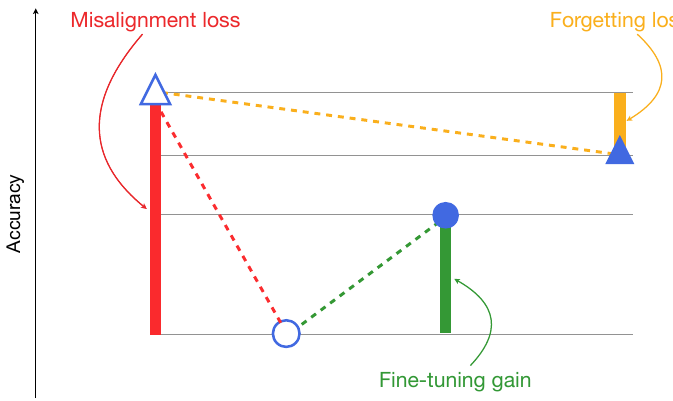
Figure 3. Example of result visualization.